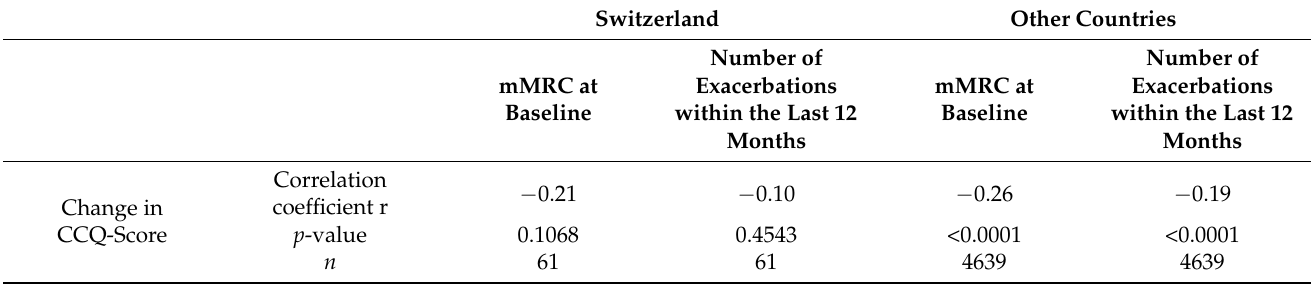
Figure 3. Pearson Correlation between CCQ score and mMRC at baseline and number of exacerbations within the last 12 months. ( A ) Pearson Correlation between CCQ score and mMRC at baseline in Switzerland; ( B ) Pearson Correlation between CCQ score and mMRC at baseline in other countries; ( C ) Pearson Correlation between CCQ score and number of exacerbations within the last 12 months in Switzerland; ( D ) Pearson Correlation between CCQ score and number of exacerbations within the last 12 months in other countries. Table 2. Pearson correlation between the CCQ score and mMRC at baseline, and the number of exacerbations within the last 12 months.